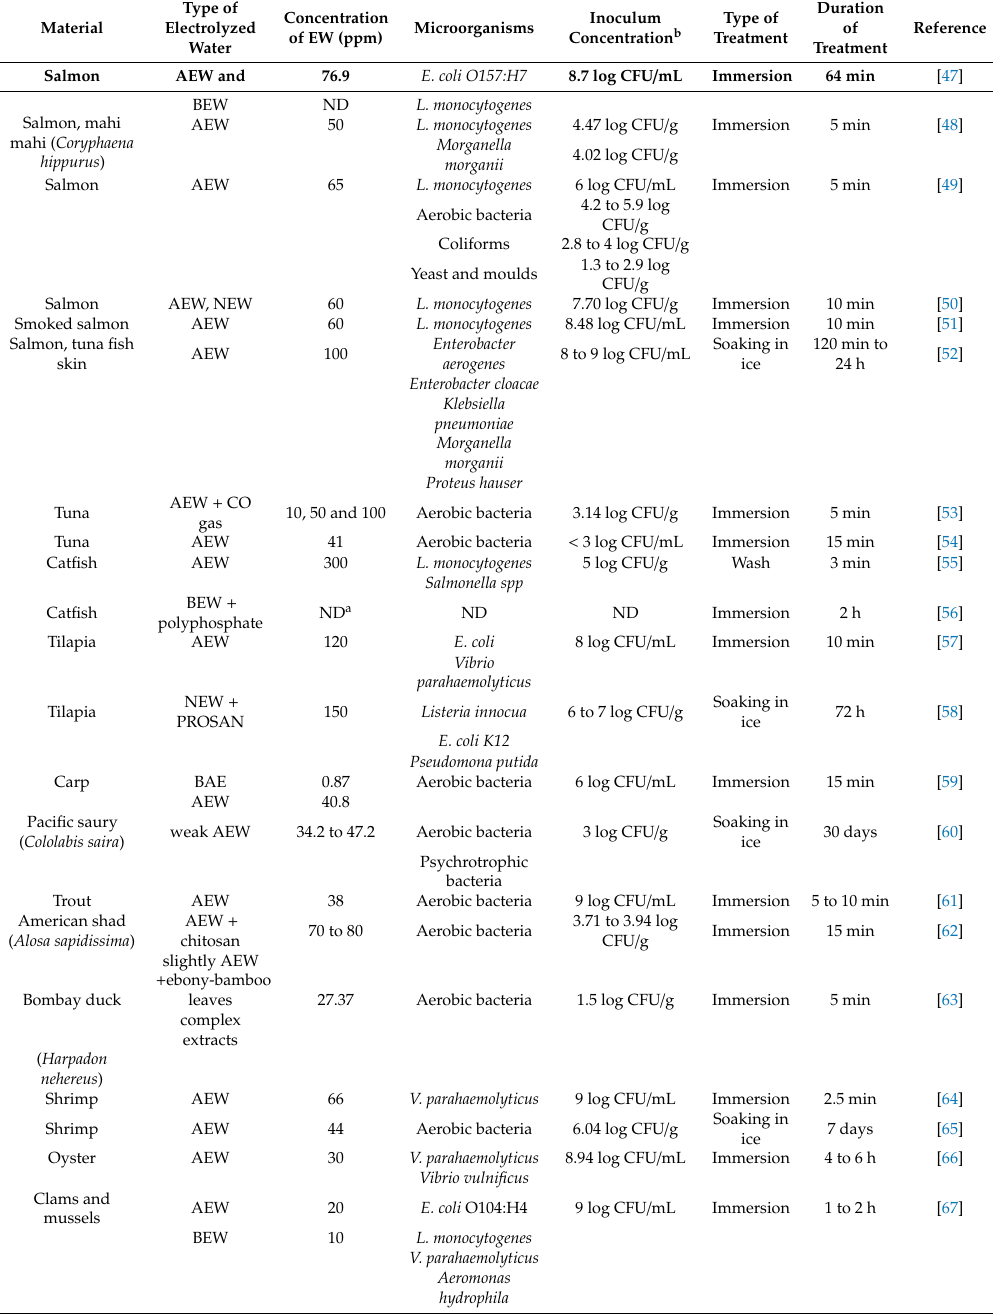
Table 3. Evaluations of electrolyzed water in